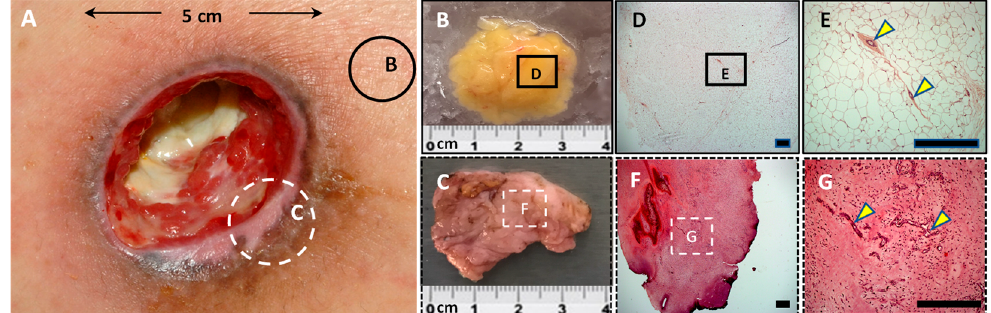
Figure 2. Pressure ulcers. ( A ) Representative image of pressure ulcers (PUs) in SCI patients. Macro- scopic tissue: Biopsies were taken from the PU area, including a subcutaneous white adipose tissue (s-WAT) sample peripheral to the ulcer ( B ) and a sample from the ulcerated tissue area ( C ). Micro- scopic tissue: Histological sections analyzed in s-WAT ( D , E ) and ulcerated tissue ( F , G ) are shown. Blood vessels (yellow triangles) were also detected. Scale bars: 500 µm ( D , F ) and 100 µm ( E , G ).